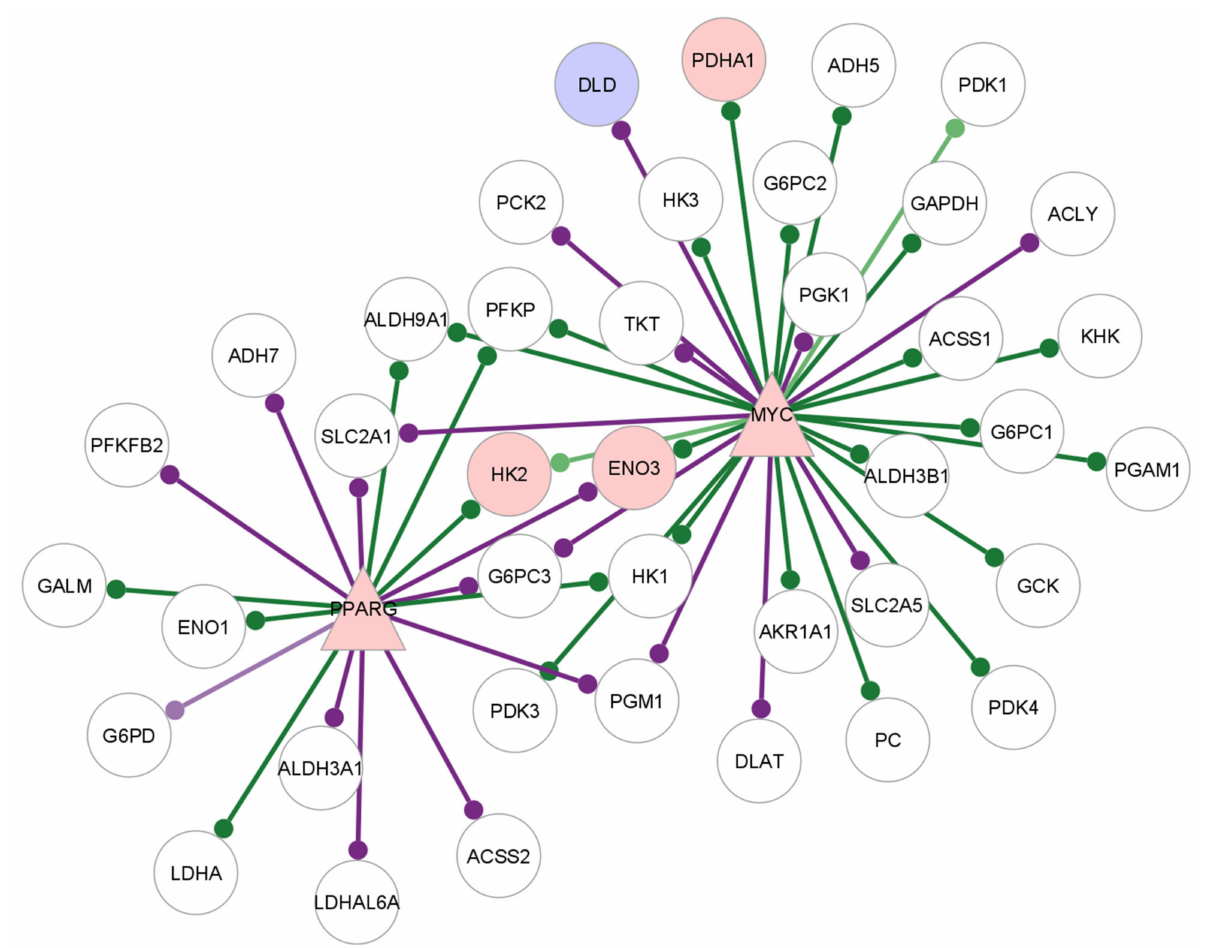
Figure 9. Subgraph of MYC , PPARG and INSR and their target genes in the GeneHancer annotated network of edges with significantly different edge weights between untreated RA and healthy samples, in CD8 + Temra cells. The differentially expressed transcription factors that link to the enzymes are shown. Triangles indicate transcription factors and circles indicate target genes. Node color shows the direction of differential expression: red nodes are over-expressed, blue nodes are under-expressed and white nodes are not differentially expressed. The presence of an edge between a TF and a target gene refers to a significant difference in the edge weights of that gene pair between untreated RA samples and healthy samples. Purple edges show higher edge weight in RA, and green shows higher edge weight in healthy